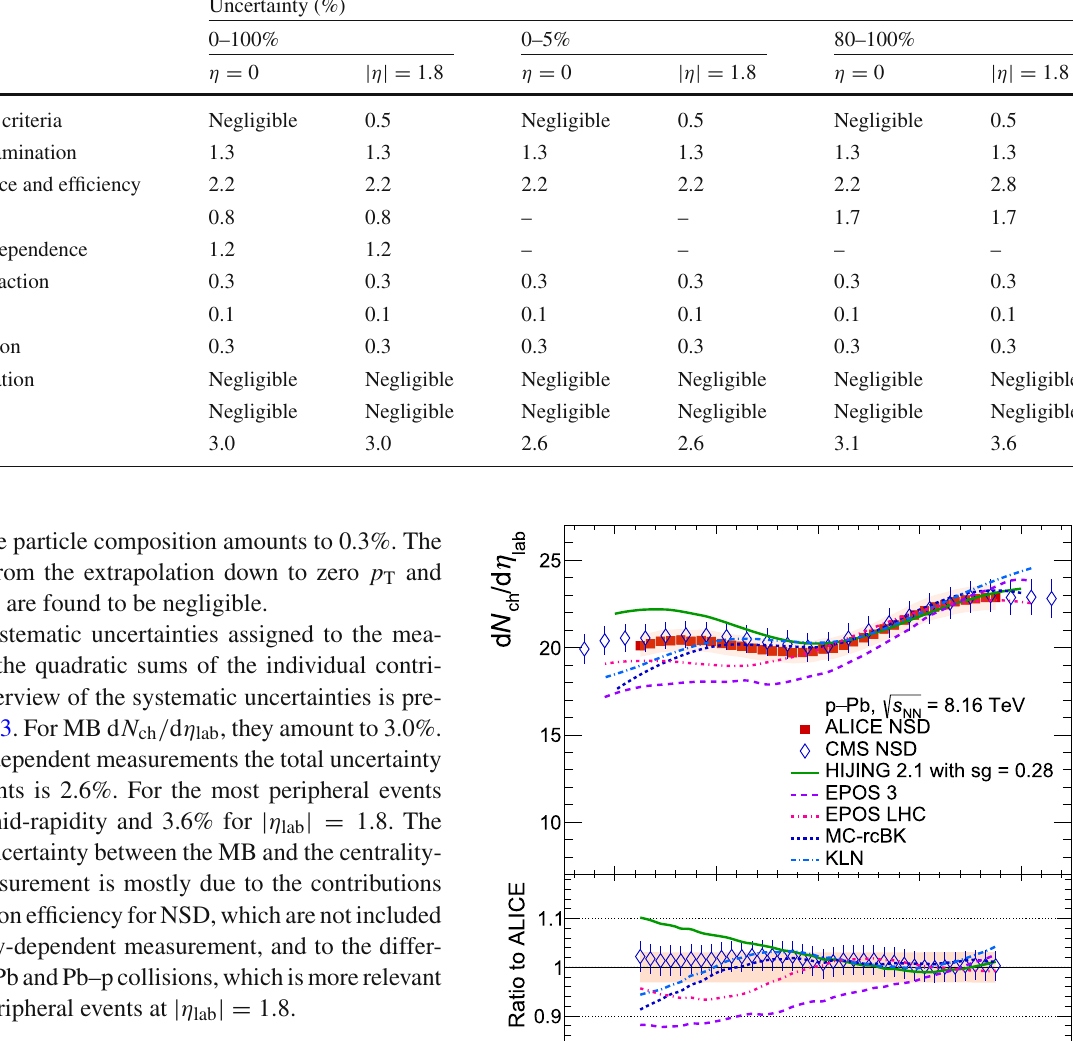
The model describes well both the normalisation and the shape of the distribution for the Pb-going side, while it over- estimates the p-going side, showing a symmetric behaviour, as for the p–Pb collisions at 5.02 TeV. The d N ch / d η lab versus η lab is compared with two different versions of EPOS. EPOS LHC [17] is a tune of EPOS 1.99 based on LHC data. It is designed to describe all bulk properties of hadronic inter- actions and based on Gribov-Regge theory for partons.